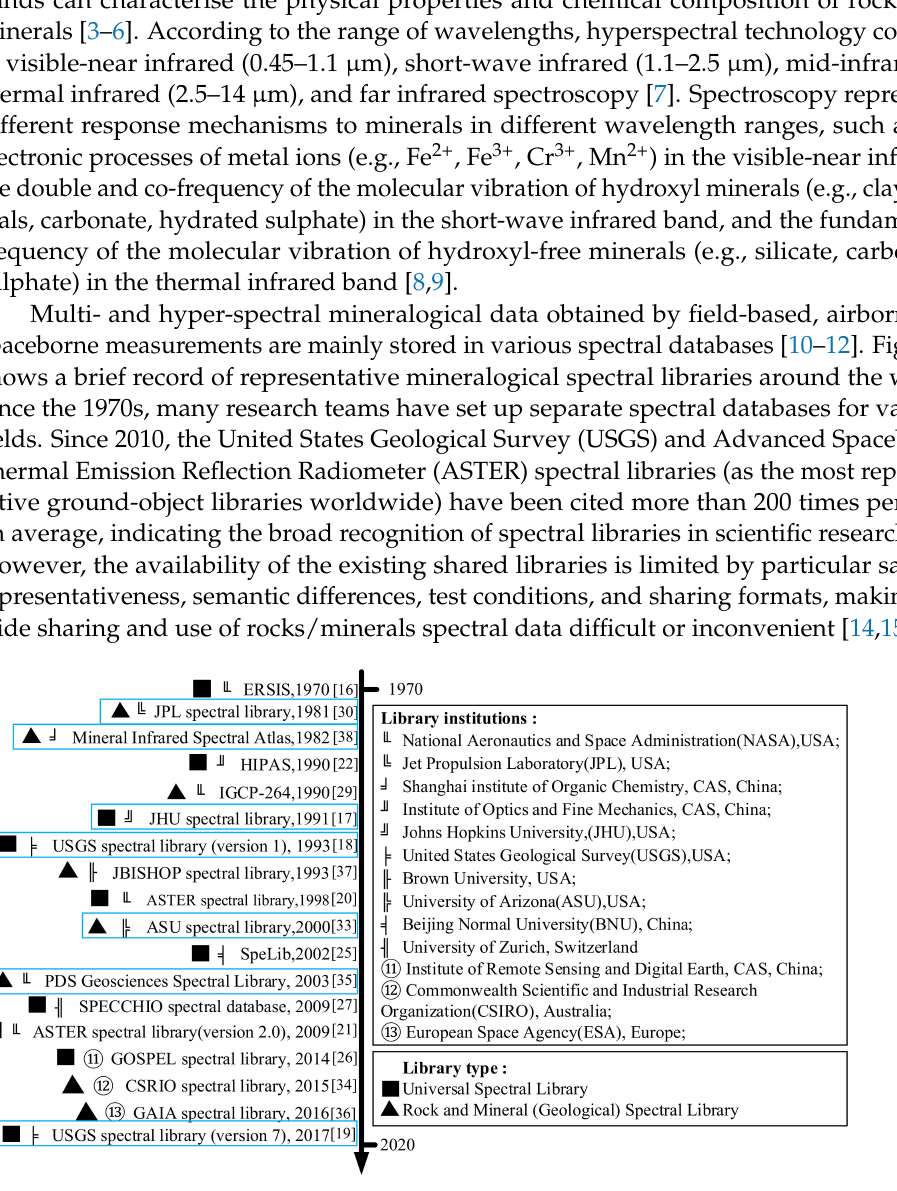
Figure 1. Timeline of mineralogical spectral libraries. The spectral libraries currently used to build RockSL were selected by the blue